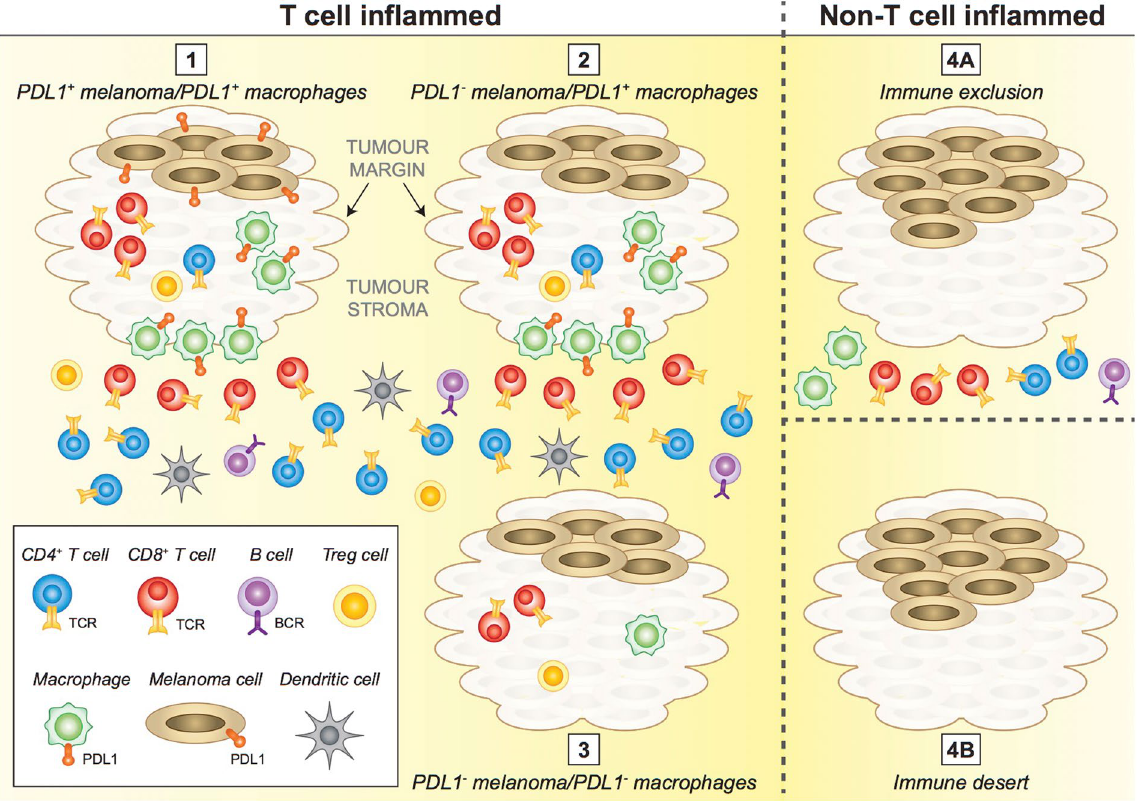
Figure 6. Conceptual diagram to depict metastatic melanoma immune context. Immune context of metastatic melanoma can be categorised into four distinct categories. Categories 1–3 are ‘T cell inflamed’ and characterised by IT CD8 + T cells and Treg, plus CD8 + T cells at the TM; CD4 + T cells, B cells and CD11c + (likely dendritic cells) are in the tumor stroma. Category 1 also has PDL1 + melanoma and PDL1 + macrophages (IT and at TM). In Category 2, melanoma cells are PDL1 − , but macrophages are PDL1 + (IT and/or TM). In category 3, melanoma and macrophages cells are PDL1 − . Category 4 includes the T cell excluded (4A) where all immune cells are in the stroma and both melanoma and macrophages are PDL1 − , or immune desert (4B) where no immune cells are